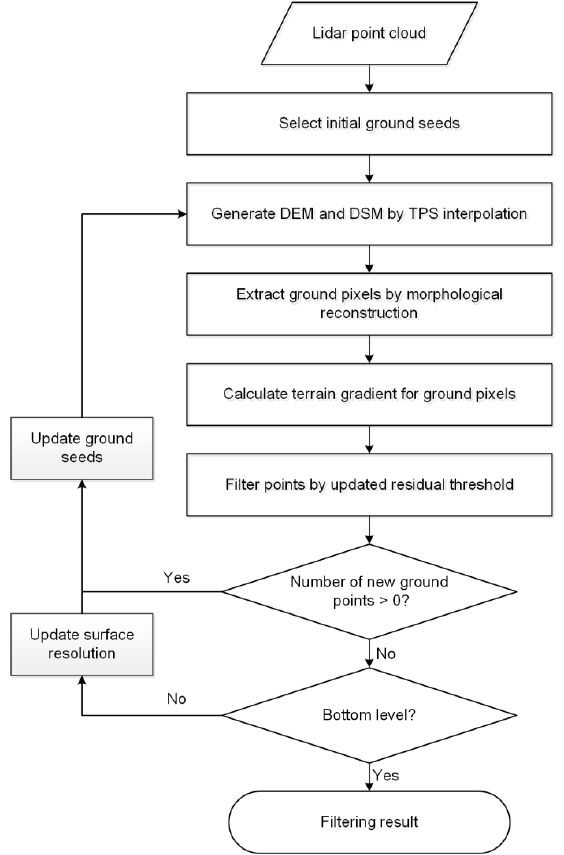
Figure 1. Multilevel adaptive filter (MAF) flowchart.